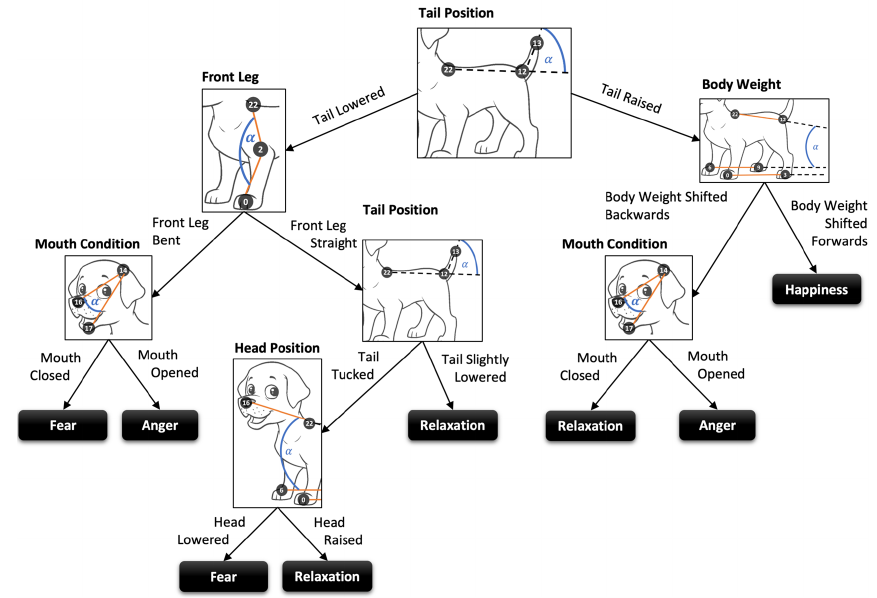
Figure 12. Explanatory illustration of the decision tree.